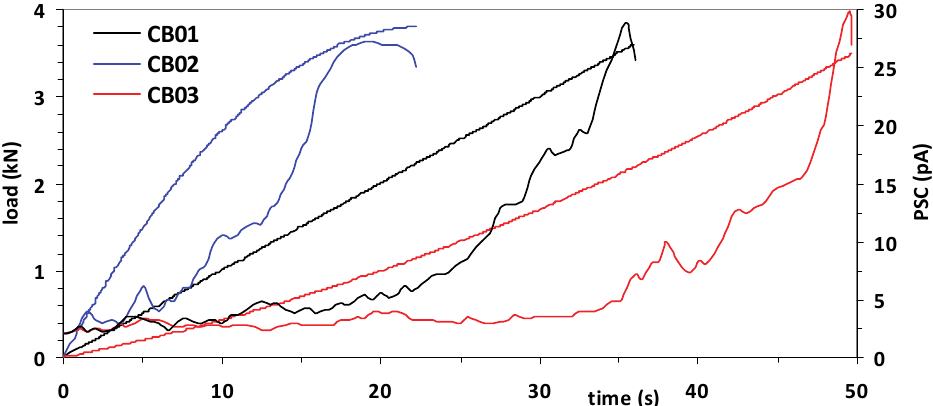
Figure 2: The time variation of the applied 3PB load and the corresponding time variation of the PSC, during all three experiments conducted.